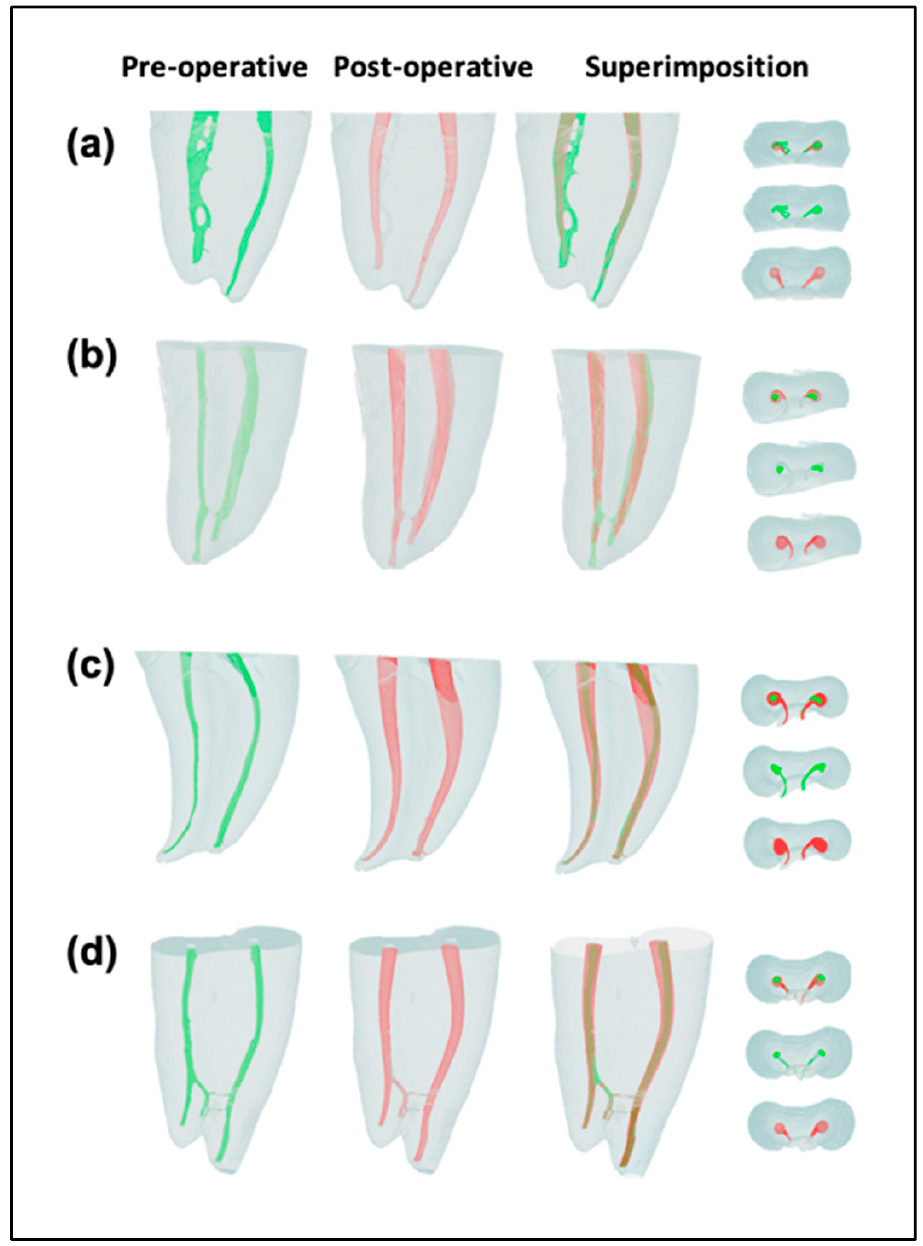
Figure 1. 2D and 3D representations of the segmentations on mesial roots: HyFlex CM without flaring ( a ), HyFlex CM with flaring ( b ), 2Shape without flaring ( c ), 2Shape with flaring ( d ). Root canal pre-operative surfaces are indicated in green and post-operative in red. The non-instrumented canal wall surfaces were reported in green in the superposition view.